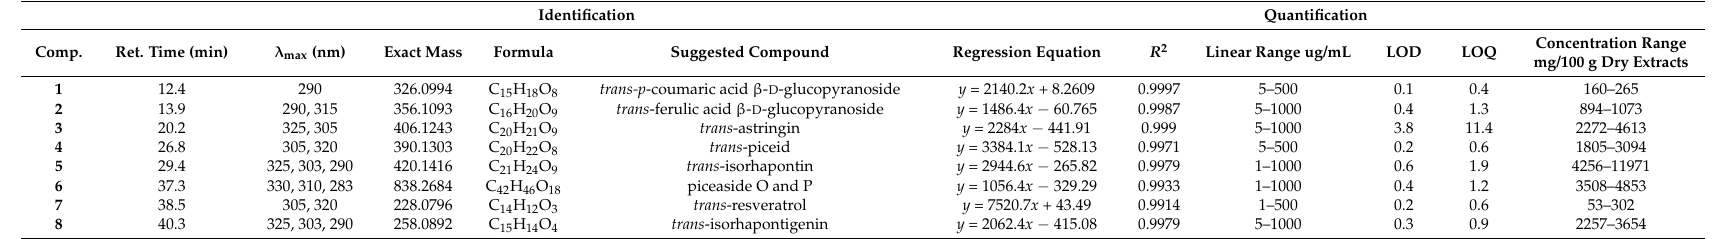
Table 2. Identification and quantification data for the 8 phenolic compounds isolated from black spruce bark